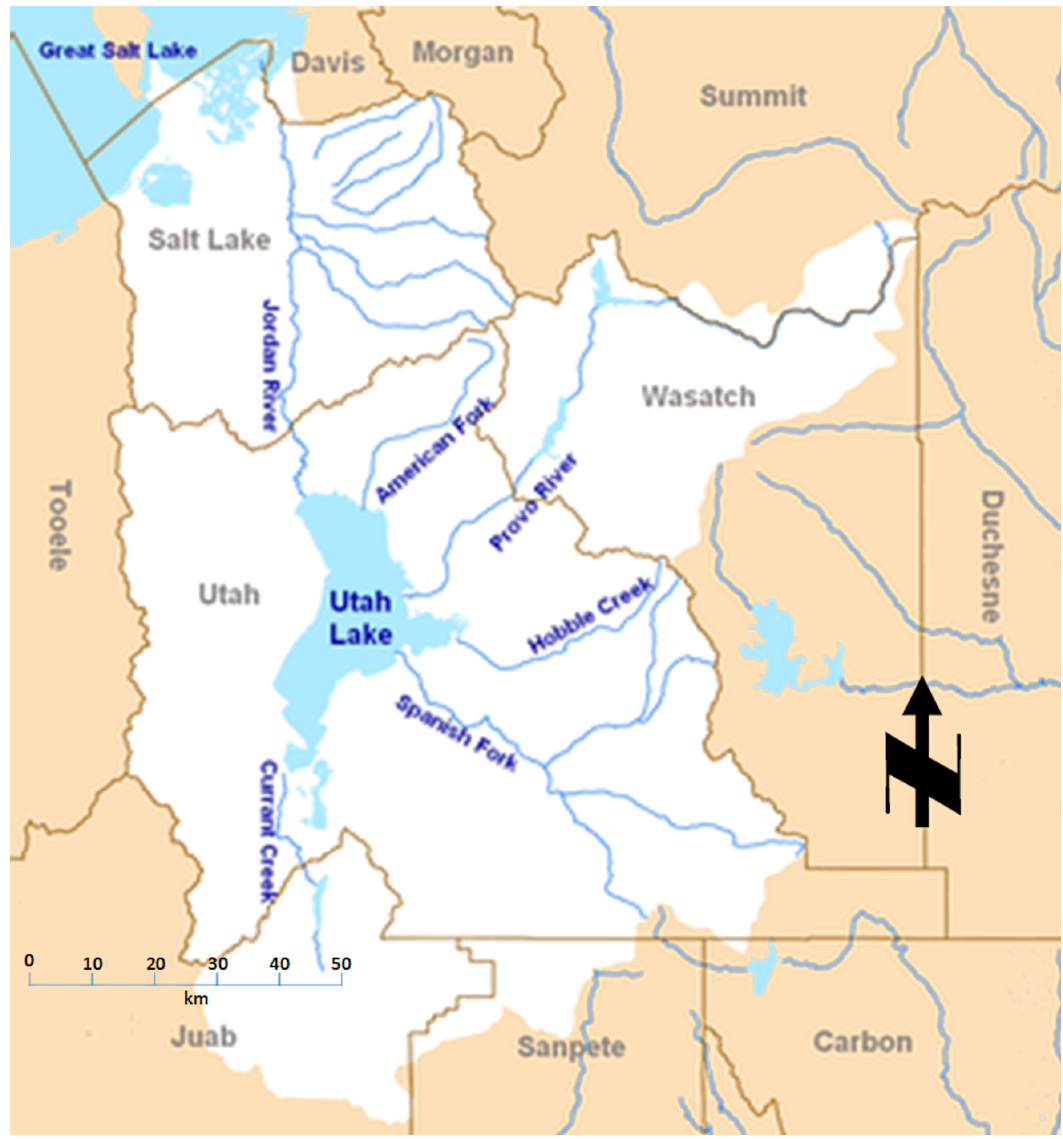
Figure 2. The Jordan River basin that contains both the inflows and outflow for Utah Lake (figure created from